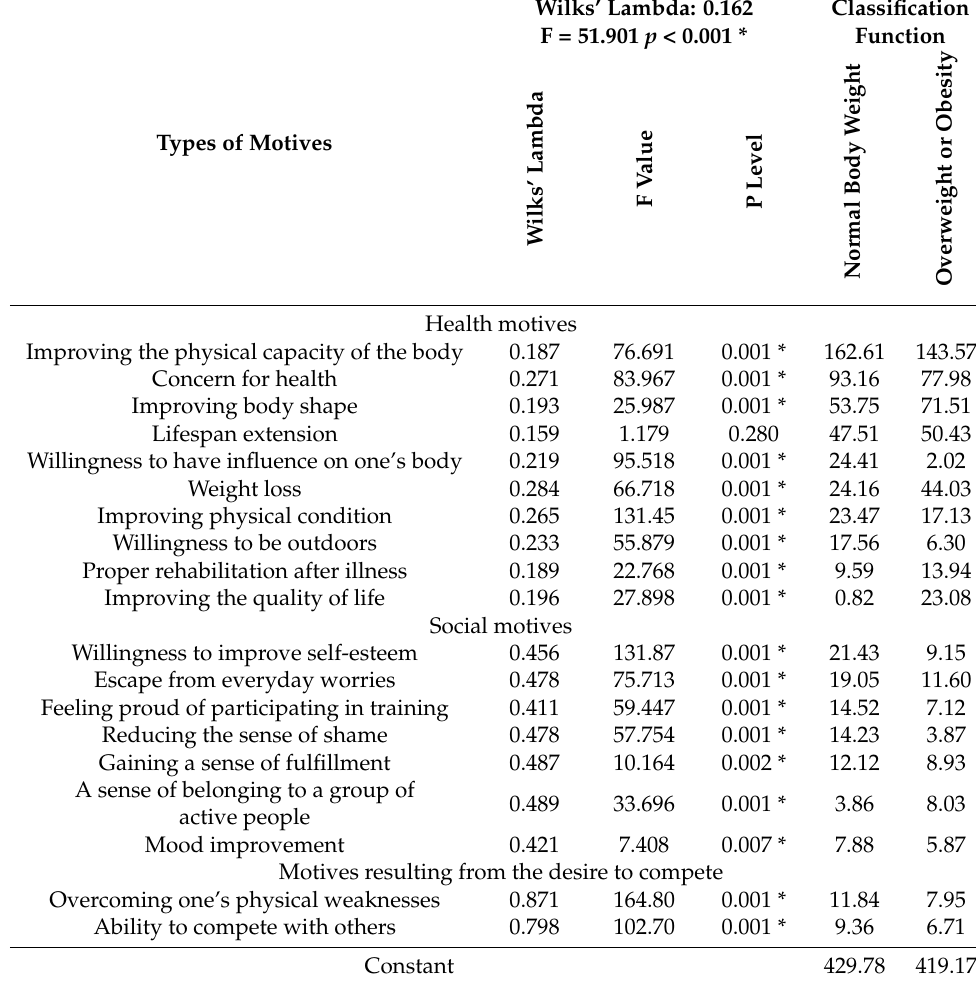
Table 4. Motives affecting participation in NW